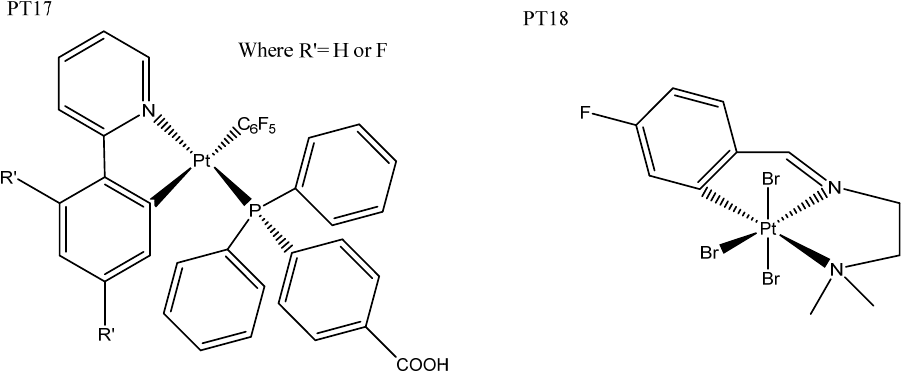
Figure 11. Cyclometallated platinum complexes PT17a, where R’ = H; PT17b, where R’ = F [88]; and PT18 [89].